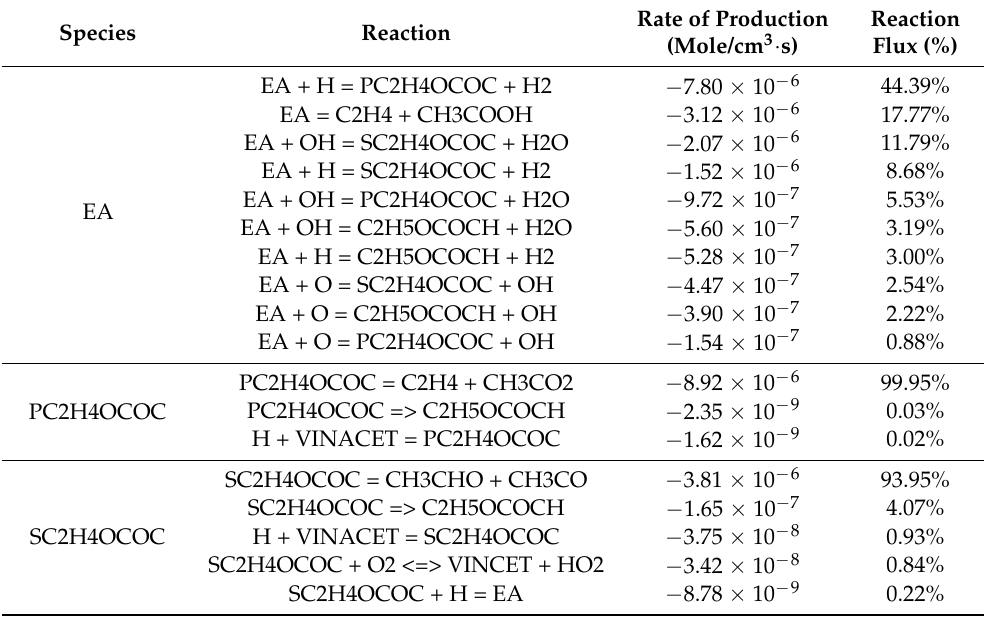
Table 2. Rate of production for main species and reactions calculated by the skeletal mechanism at φ =